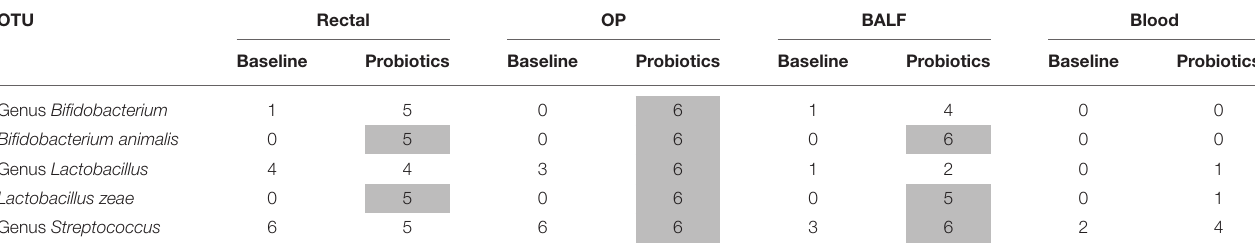
TABLE 2 | Number of cats (out of 6) in which the predominant probiotic operational taxonomic units (OTUs) were sequenced at baseline and after probiotic administration. OTU Rectal OP BALF Blood Baseline Probiotics Baseline Probiotics Baseline Probiotics Baseline Probiotics